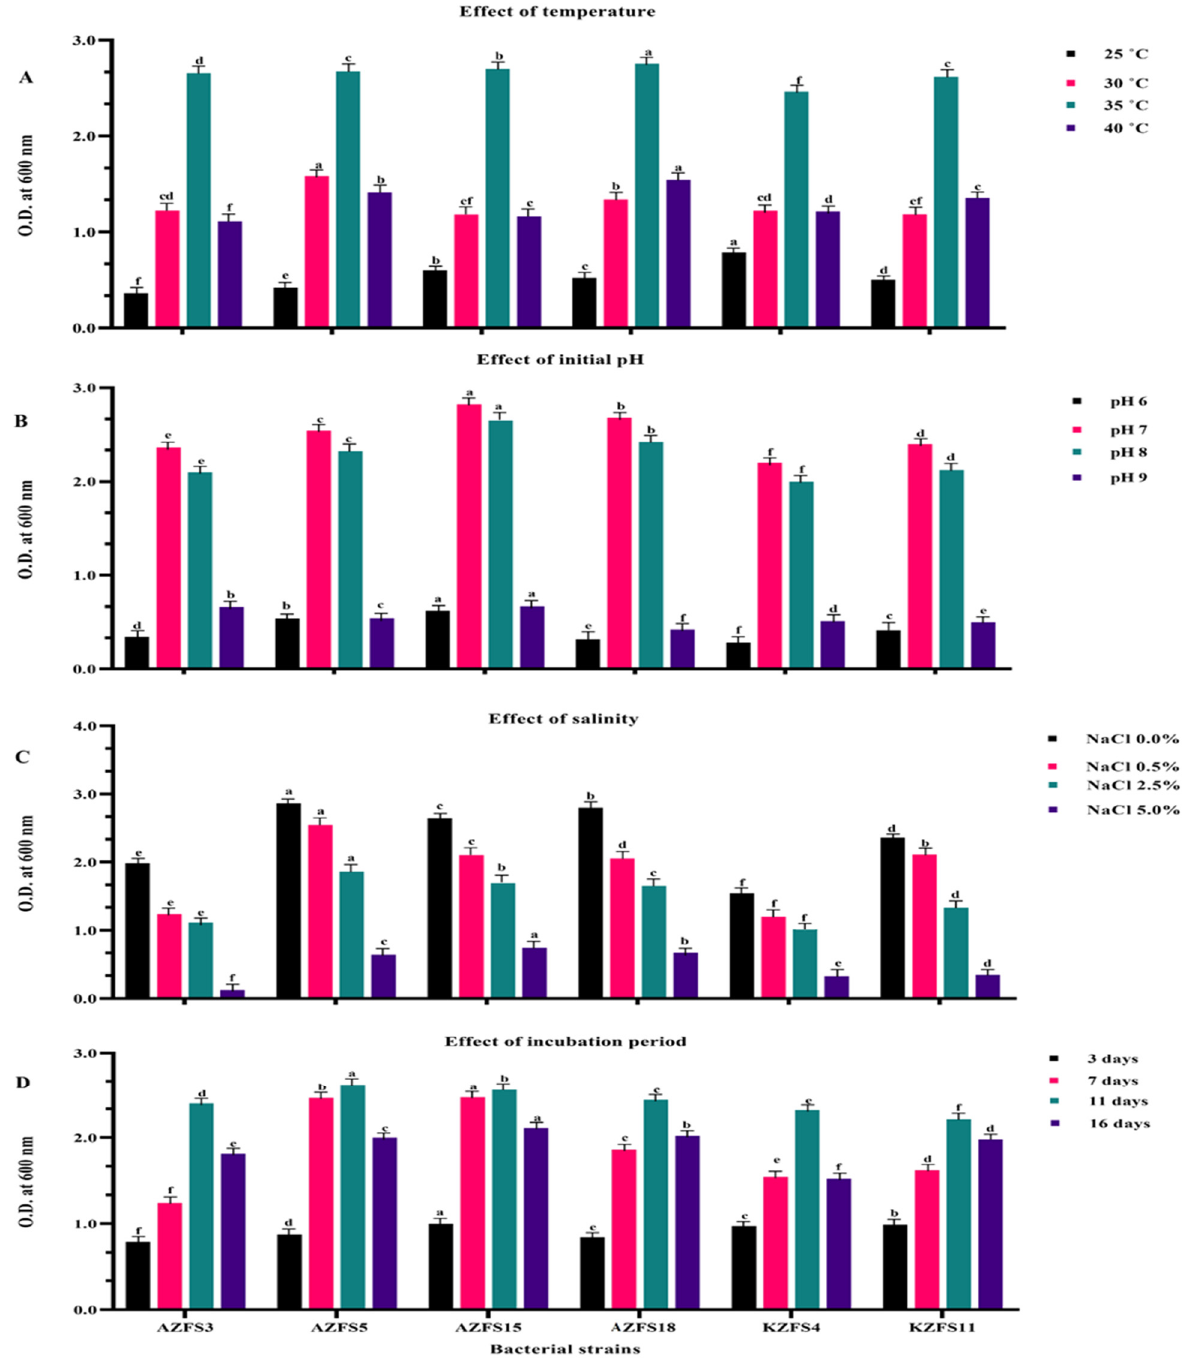
Figure 2. Bacterial growth of the tested six bacterial strains on MS broth with FBD-CAP. Mixture 50 mg/L, ( A ) effect of temperature, ( B ) effect of initial pH, ( C ) effect of salinity, and ( D ) effect of incubation period. Means and standard deviations of three replicates. Different letters on top of the bar indicate significant differences ( p < 0.05).